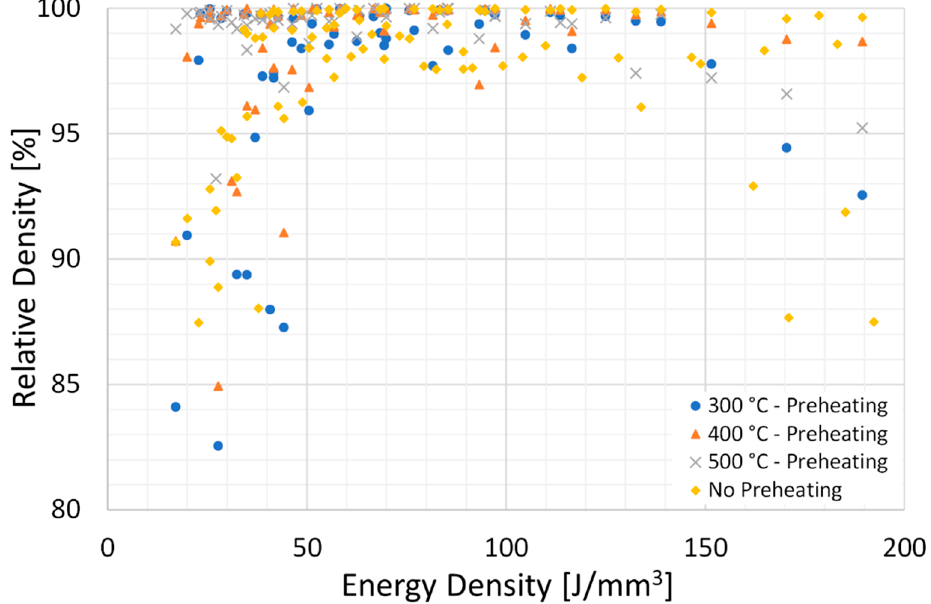
Figure 3. Relative density vs. energy density for the DoE of 1.2343/H11 tool steel.